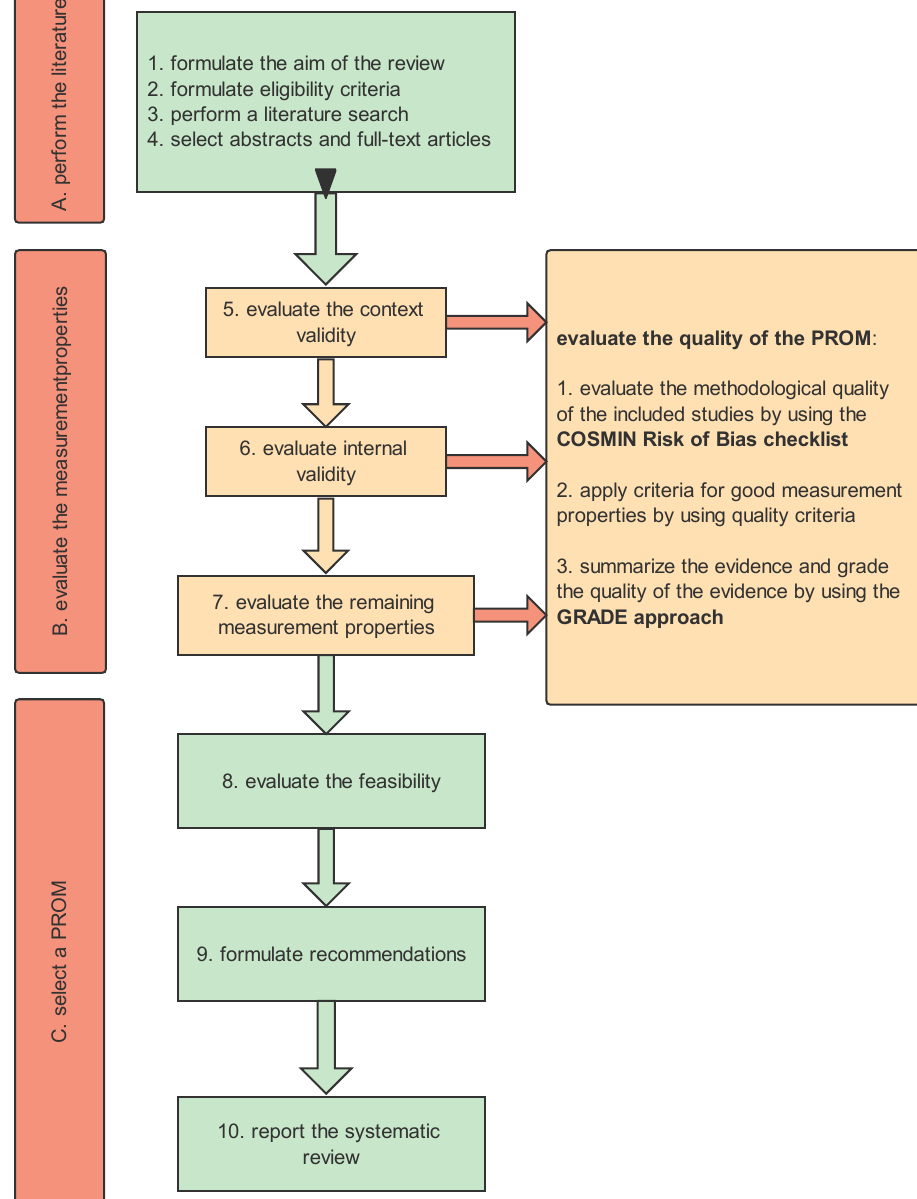
Figure 1. Ten steps for conducting a systematic review of PROMs.